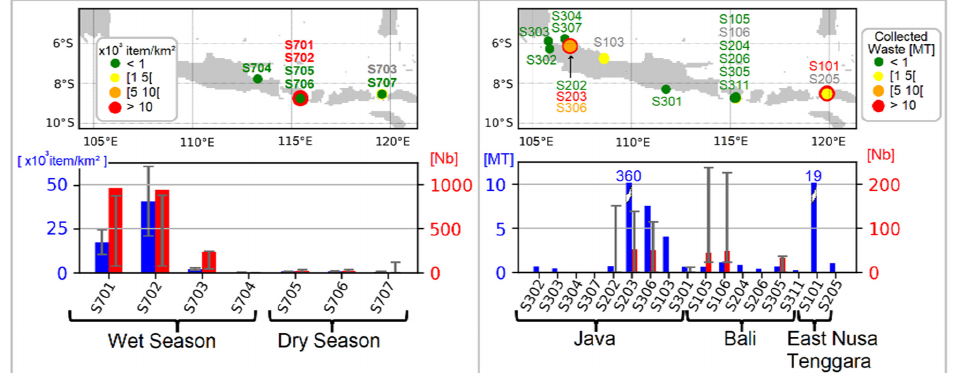
Figure 8. Comparison between our numerical simulation and observations from ( left panel ) cleaning sessions presented by [43] at the APEC Bali workshop and ( right panel ) visual surveys presented in [41]. In the left panels, the units are in metric tons (MT), and in the right panels, units are in 10 (cid:2871) 𝑖𝑡𝑒𝑚/km (cid:2870) . Maps in the upper row show the different site locations. Bar plots in the lower row show in situ observations (in blue, left ordinate axis) vs. simulation results (in red, right ordinate axis). In the lower left (respectively, Right) panel, simulation results are computed as the number of particles stranded within a 20 km range from the site location and during the 7 (respectively, 60) days prior to the cleaning session (respectively, end of the visual survey). For simulation results, grey error lines illustrate the 5th and 95th percentiles of the number of stranded particles that were computed considering slight changes in time (plus or minus 7 days around the cleaning session date or minus 30 days from the end of the visual survey) and position (10 km range from the site loca- tion). For observation results, grey error lines illustrate the study error, when available. The second set of comparisons was performed using observations from PS. The pur- pose of the PS study was not to compare the relative amounts of waste between monsoons but to clean beaches and estimate the weight of the waste collected. It appears that, apart from on Bali, no beaches were cleaned during both the wet and dry seasons; thus, the monsoonal variability in strandings could not be compared in this case. The correlation between the simulation and observations was not as striking as with the GS dataset (lower right panel of Figure 8), and the specific conditions of each site need to be analyzed.